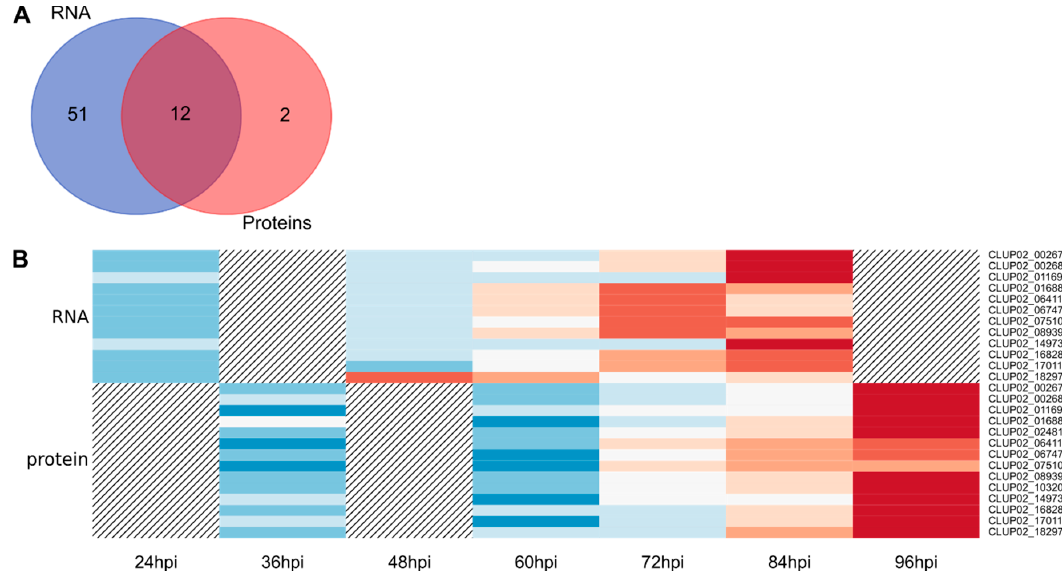
(Figure 1D). Regarding CAZymes identified by mass spectrometry, all, except for CLUP02_07510 (which was detected later from 72 hpi to 96 hpi), were detected from 36 hpi to 96 hpi, and their abundance increased throughout the infection process (Figure 5B). Identified CAZymes were mainly involved in degradation of fungal or plant cell wall, glycosylation of proteins, energy, storage and recovery or synthesis of fungal cell wall (Table 3).